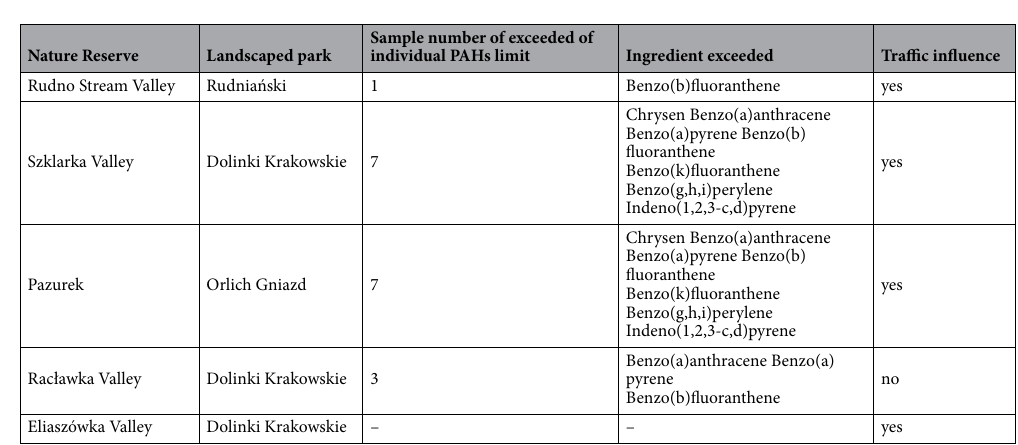
Table 6. PAH content in soils collected in nature reserves in Malopolska region.